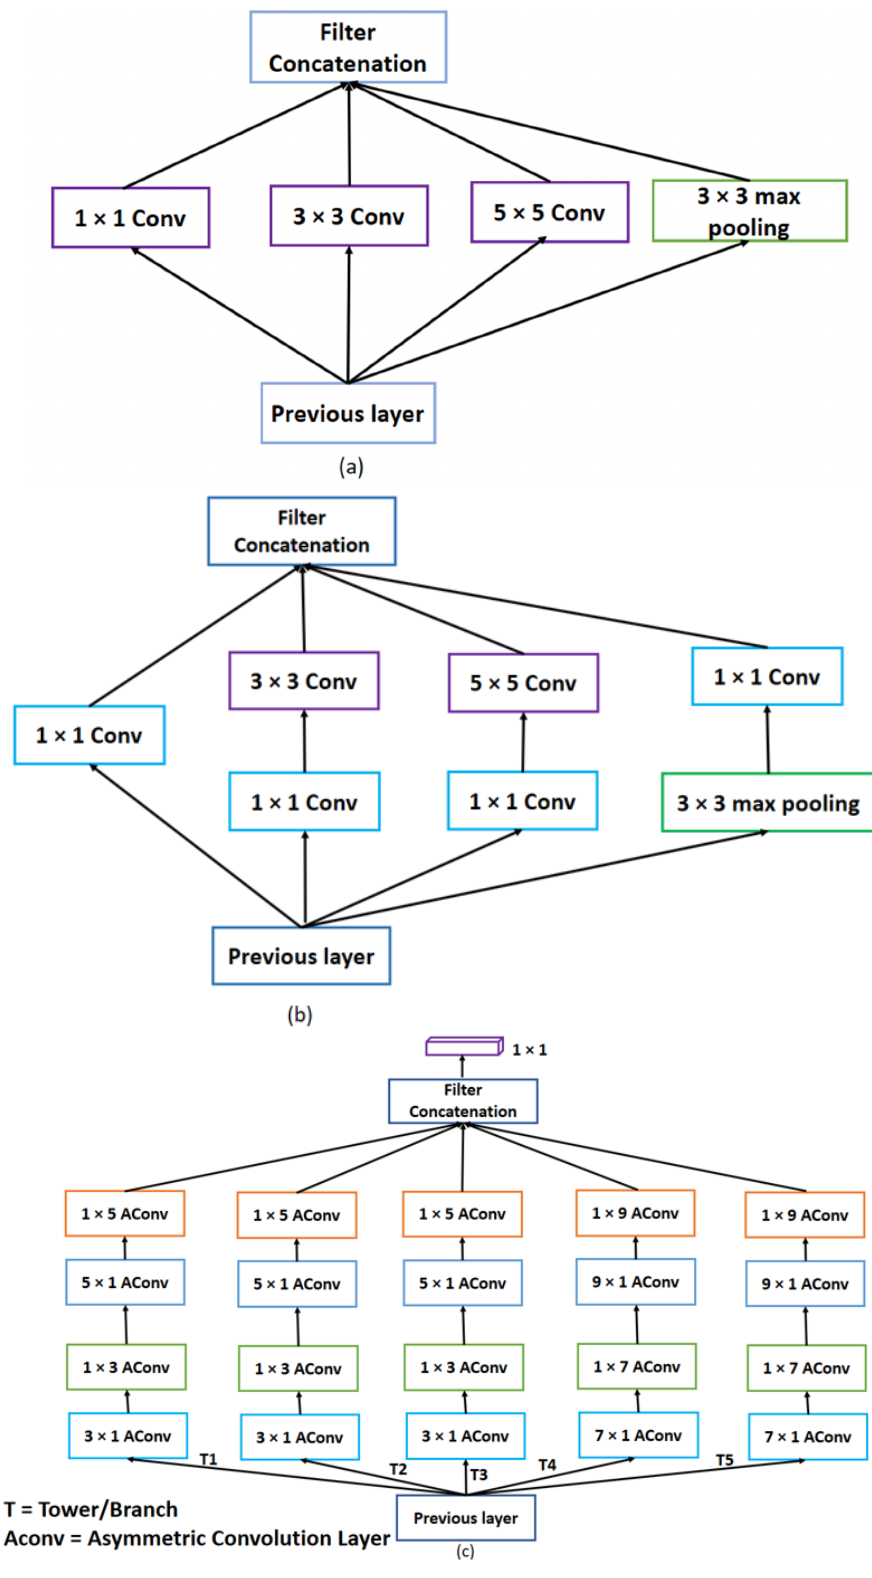
Figure 4. Inception block with different towers [54] used for multi-scale reconstruction stage-II. ( a ) Inception module, naive version; ( b ) inception module with dimension reductions [55]; and ( c ) our proposed